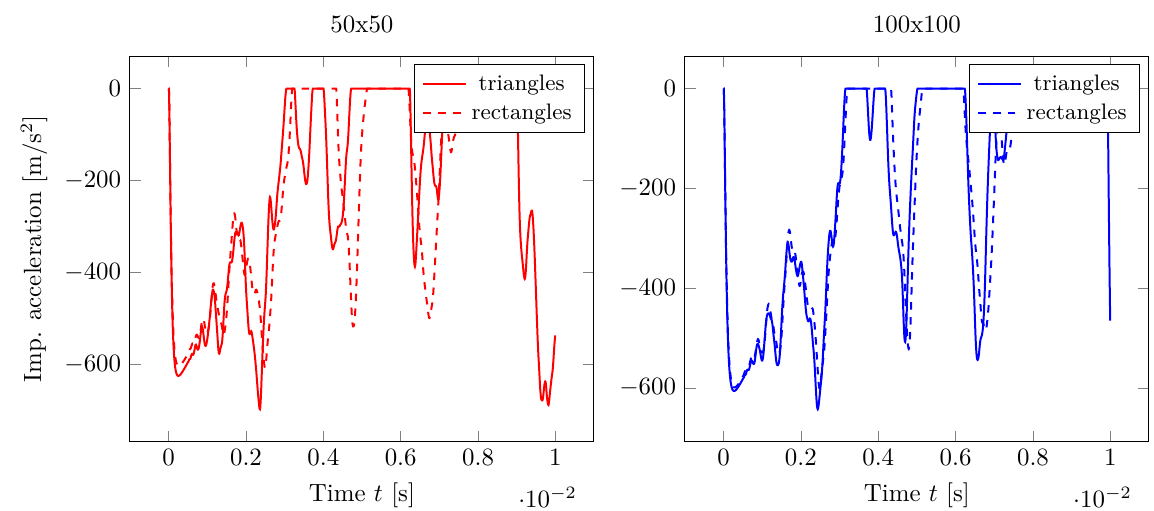
Figure 2. Evolution of impactor acceleration for triangles (solid) or squares (dashed) mesh plotted for resolution 50 × 50 (red) and 100 × 100 (blue).